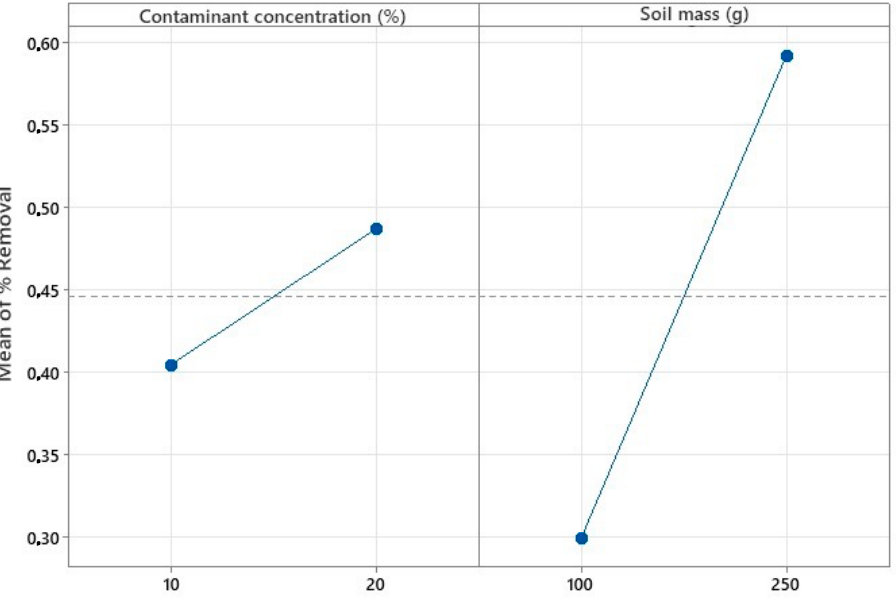
Figure 5. Contour plot of oil removal (%) vs Soil mass (g) and Washing duration (min).